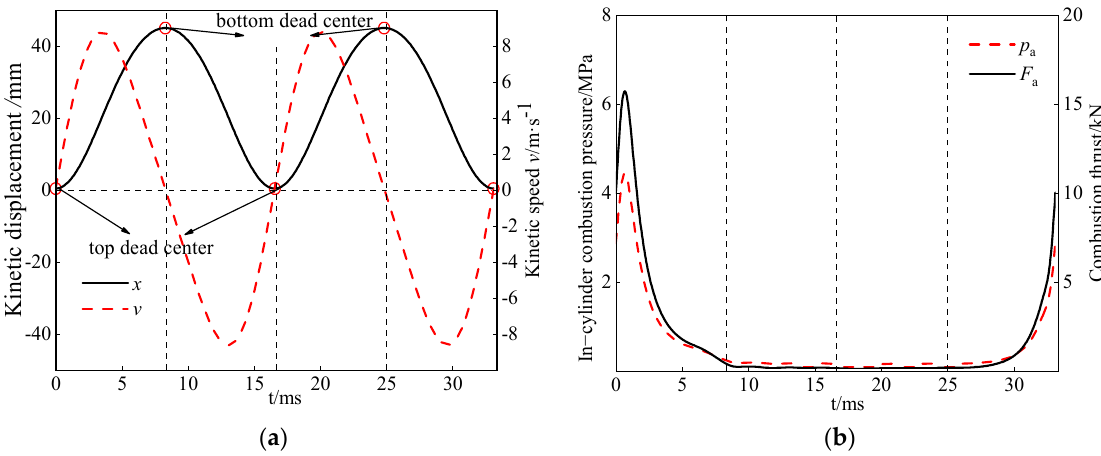
Figure 3. Dynamics simulation results: ( a ) Variation curves of piston displacement and velocity with time; ( b ) Engine in-cylinder pressure curve.